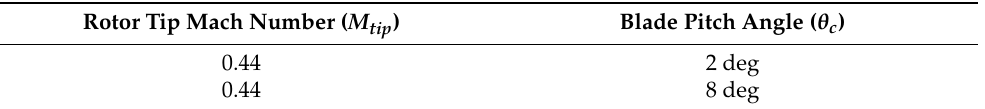
Table 1. Conditions for Caradonna-Tung case.